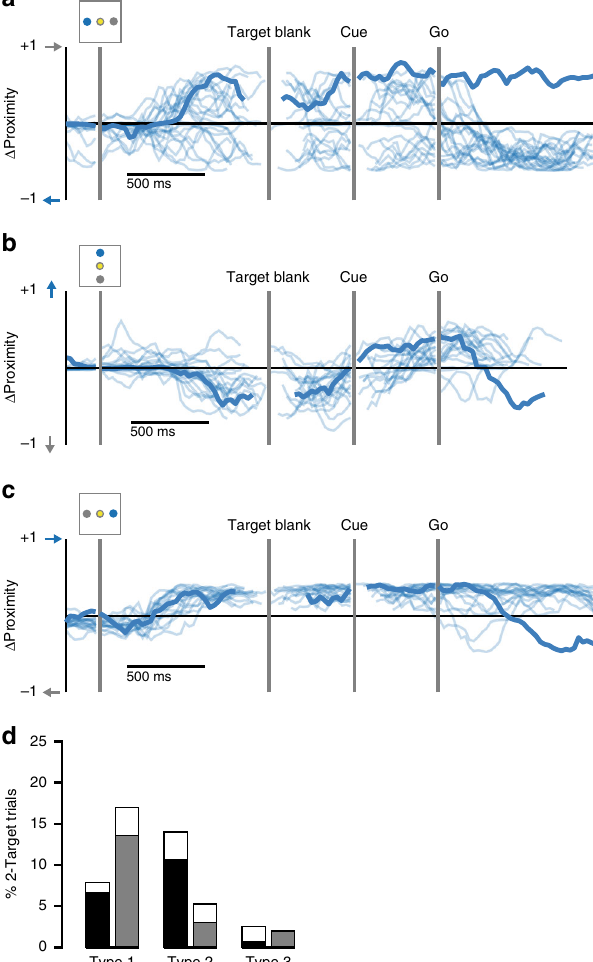
Fig. 10 Heterogeneity in types of errors. a An example error (thick line) made to the rightward target when cued to the left (monkey M, session 2). This type of error can be characterized as an early plan that is not changed even after receiving a contradictory cue (type 1). Light traces indicate all correct trials with the same leftward cue. b An incorrect reach to the bottom target (monkey C, session 1). This type of error can be characterized as a late reversion to the initial plan (type 2). c An incorrect reach to the leftward target (monkey M, session 1). This error represents a late switch away from the correct reach plan (type 3). d Histogram showing the frequency of each error type for both monkeys (monkey C, black; monkey M, gray). Filled and open segments indicate whether the errors were made to a favored or non-favored target,